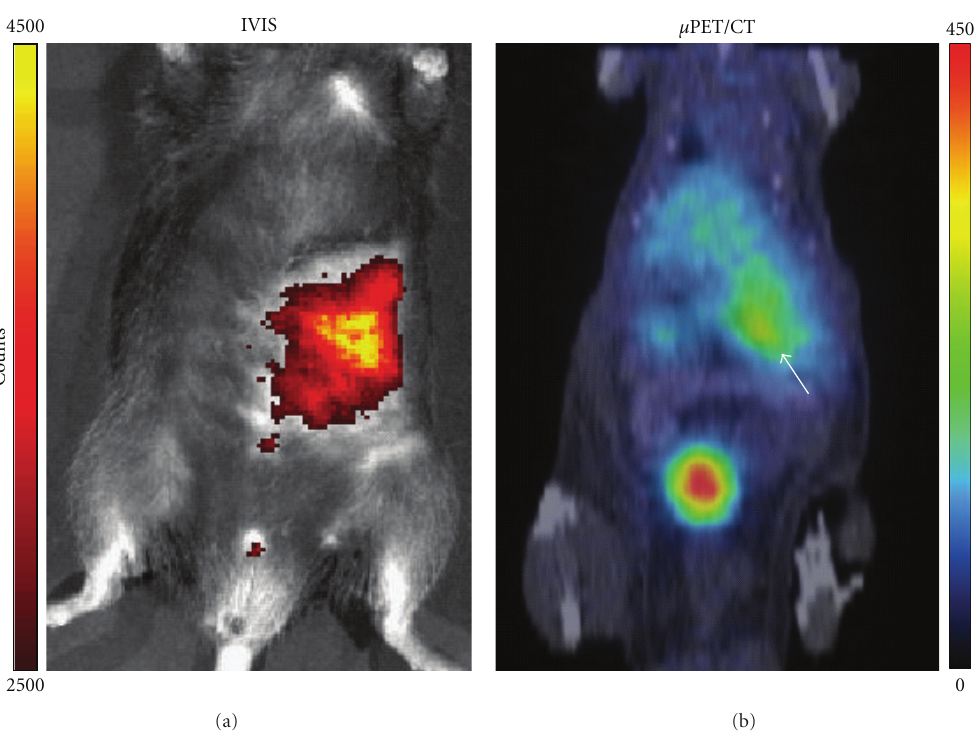
Figure 2: PET imaging of intramuscularly transplanted islets using the VMAT2 ligand [ 18 F]FE-DTBZ-d4 as PET tracer. An inbred C57BL/6 mouse was transplanted with 300 mouse islets to the left abdominal muscle. The islets were labeled with Q-tracker prior to implantation. One month later, the mouse was administered the PET tracer [ 18 F]FE-DTBZ-d4 intravenously. The tracer uptake could be detected by a μ PET/CT scanner after 60 minutes (right image, orange delineation). The corresponding location of the islets as determined by Q-tracker fluorescence emission is shown to the